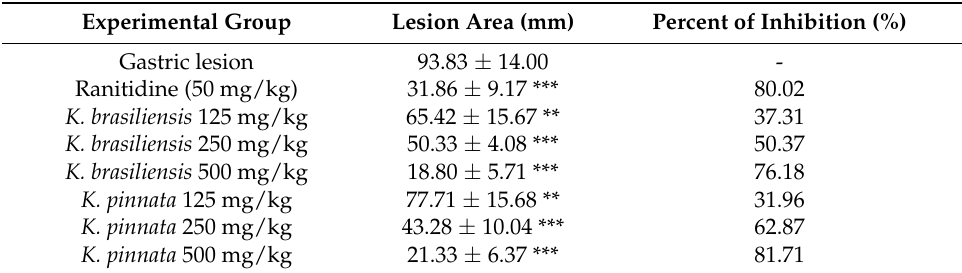
Table 3. Effect of pre-treatment with K. brasiliensis and K. pinnata leaf juice (125, 250 and 500 mg/kg) in the lesion area and percent inhibition in the ethanol-induced model.